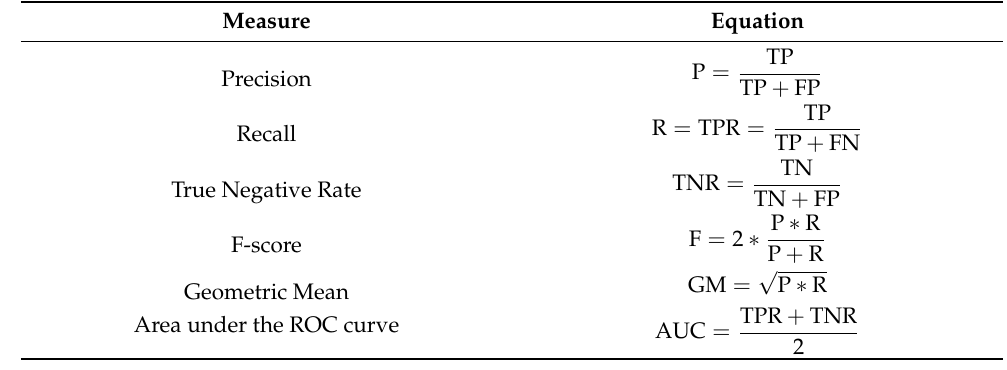
Table 3. Performance measures